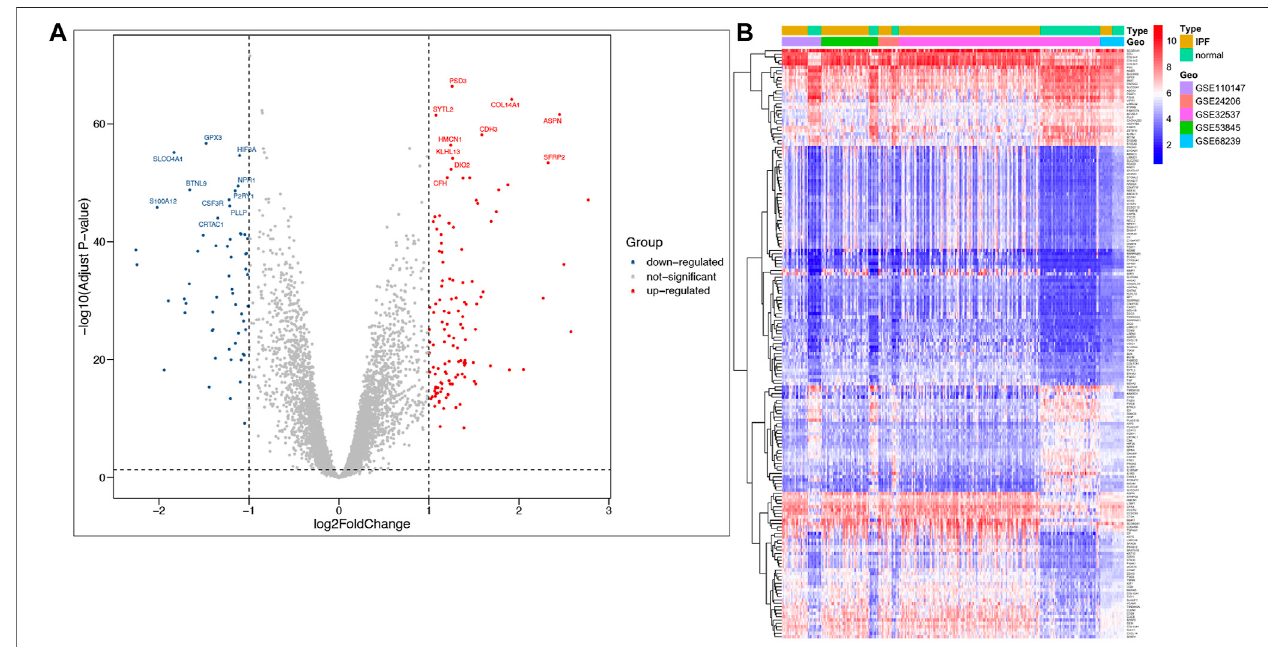
FIGURE 3 | Identi fi cation of DEGs in IPF and the enrichment of these genes in the training group. (A) Volcano plot of all DEGs. (B) Heatmap of all DEGs.